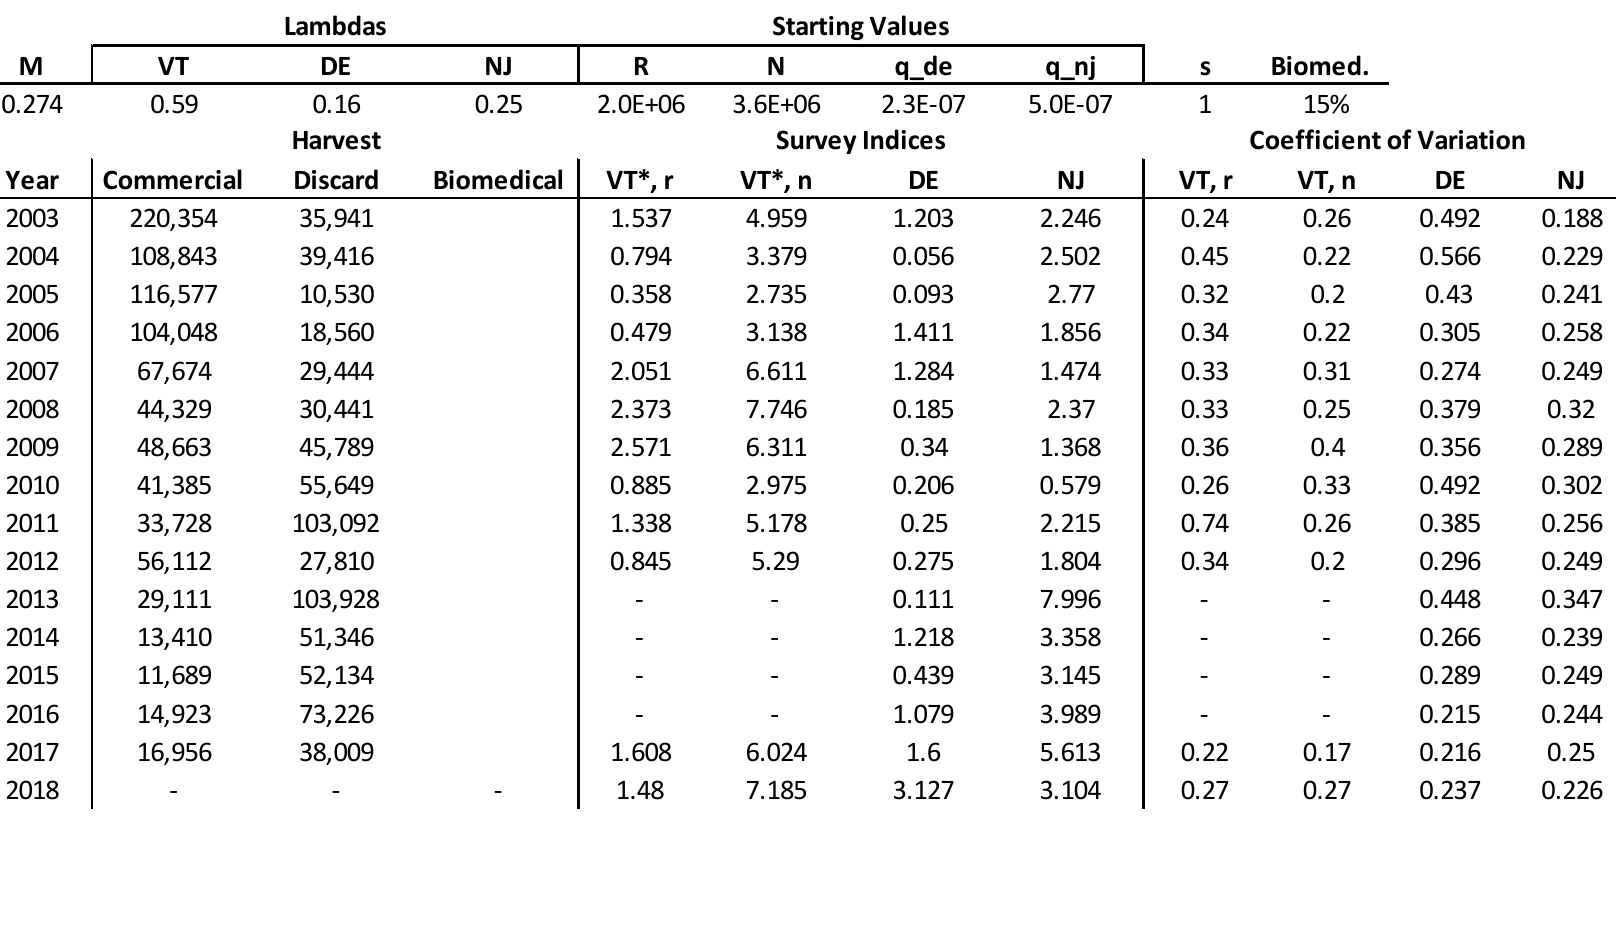
Table 43. Catch multiple survey analysis base model inputs. *Values shown in millions. CONFIDENTIAL biomedical data has been